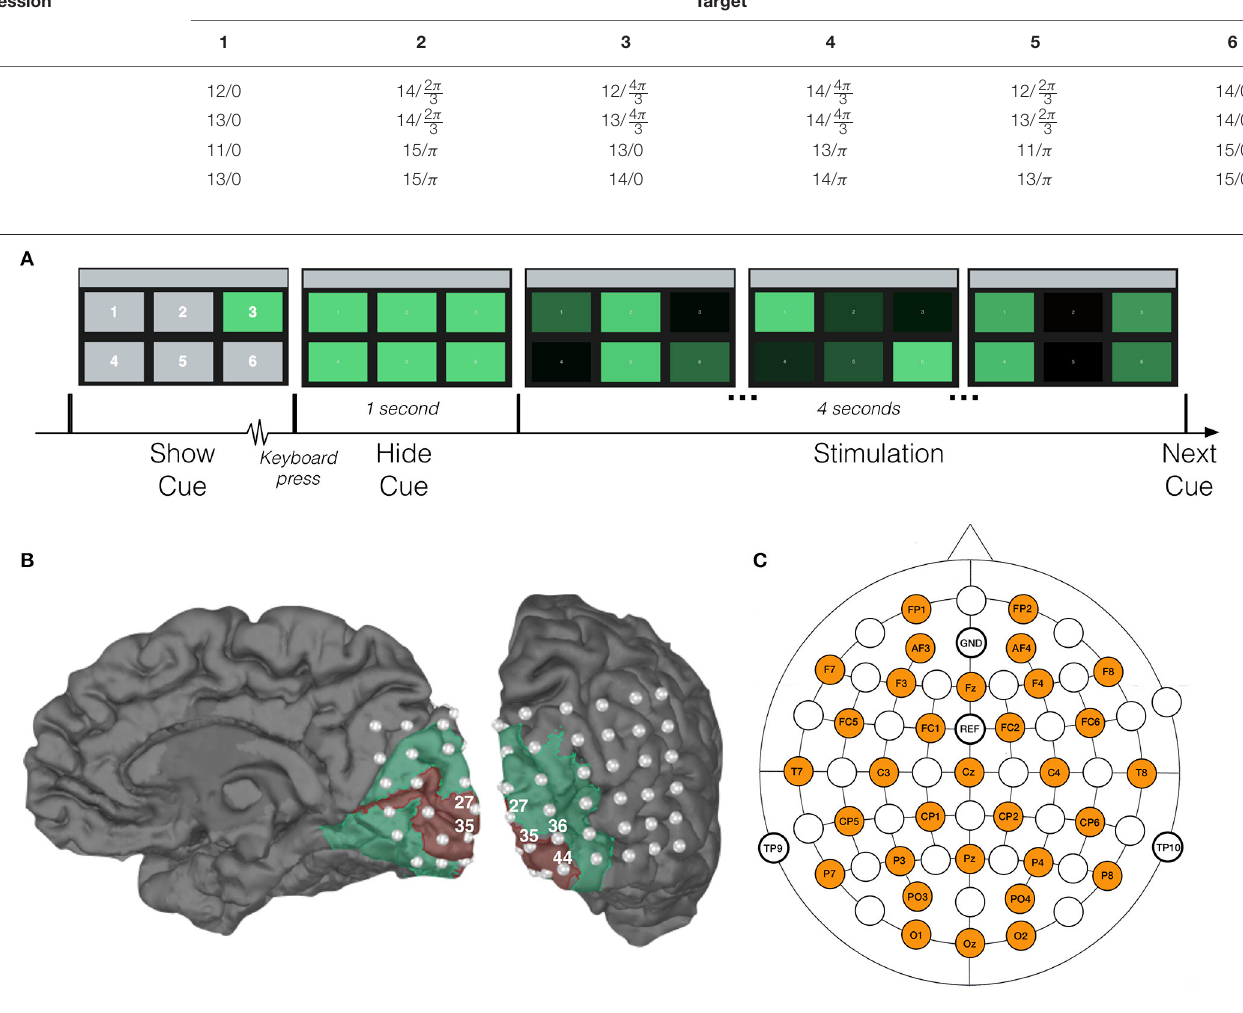
FIGURE 1 | Experimental setup. (A) Time-course of one trial with characteristic displays. For the sake of exposition, target numbers in the first display are larger than those shown to our subjects. (B) Visualization of the patient’s right hemisphere with location of implanted ECoG electrodes. Red and green areas correspond to